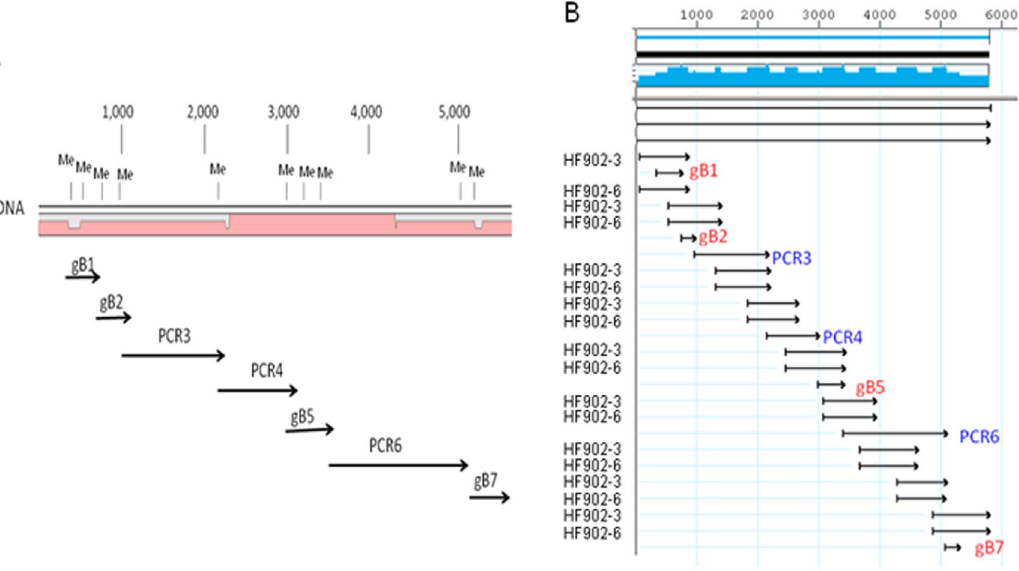
Fig. 6. Simultaneous cloning of seven fragments by Hot Fusion in order to eliminate methylation sites. (A) Distribution of Agrobacterium methylation sites (ME) on T-DNA of a vector encoding e35s driving the GUS gene. (B) Alignment of two clones (HF902-3 and HF902-6) eliminating ten Agrobacterium methylation sites on T-DNA. Four fragments (gB1, gB2, gB5 and gB7) were synthesized to readily mutate the multiple Agrobacterium methylation sites within the regions and three fragments (PCR3, PCR4 and PCR6) were amplified from the template with oligo primers containing the mutated base pairs. All seven fragments plus the vector were combined in one Hot Fusion